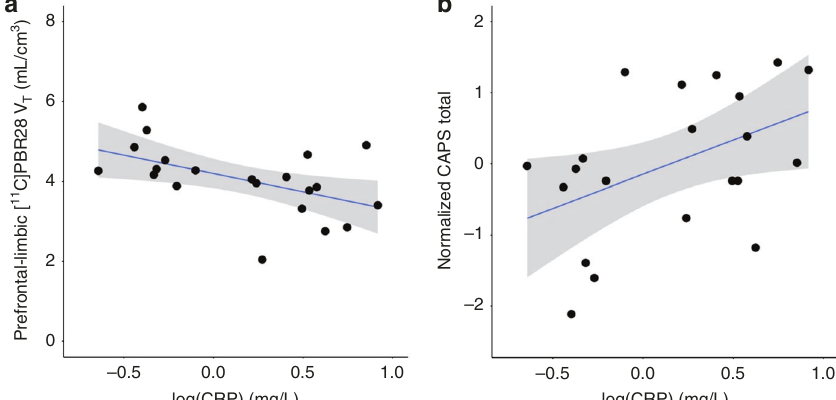
Fig. 3 CRP was negatively associated with prefrontal-limbic TSPO availability and positively associated with PTSD severity. a Lower [ 11 C]PBR28 V T was signi fi cantly associated with higher levels of CRP ( R 2 = 0.52, p = 0.005; β = − 0.92, p = 0.029) in the PTSD group ( n = 21). Displayed [ 11 C]PBR28 V T values are adjusted for genotype and sex. b Higher CRP was signi fi cantly associated with greater PTSD severity ( R 2 = 0.21, p = 0.037) in the PTSD group ( n = 21). Coef fi cient of determination and standardized coef fi cients were assessed using linear regression. Gray shading indicates 95% con fi dence